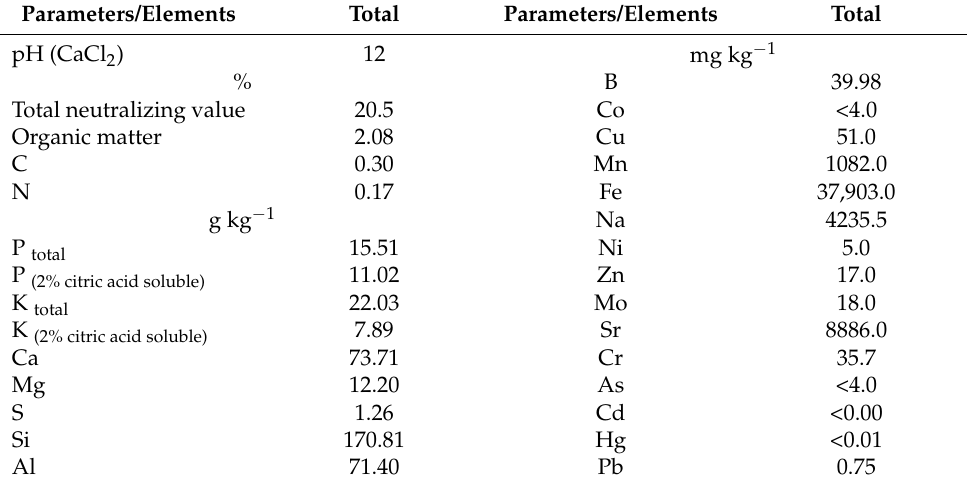
Table 1. Total and soluble chemical components of ash from Amazonian biomasses.